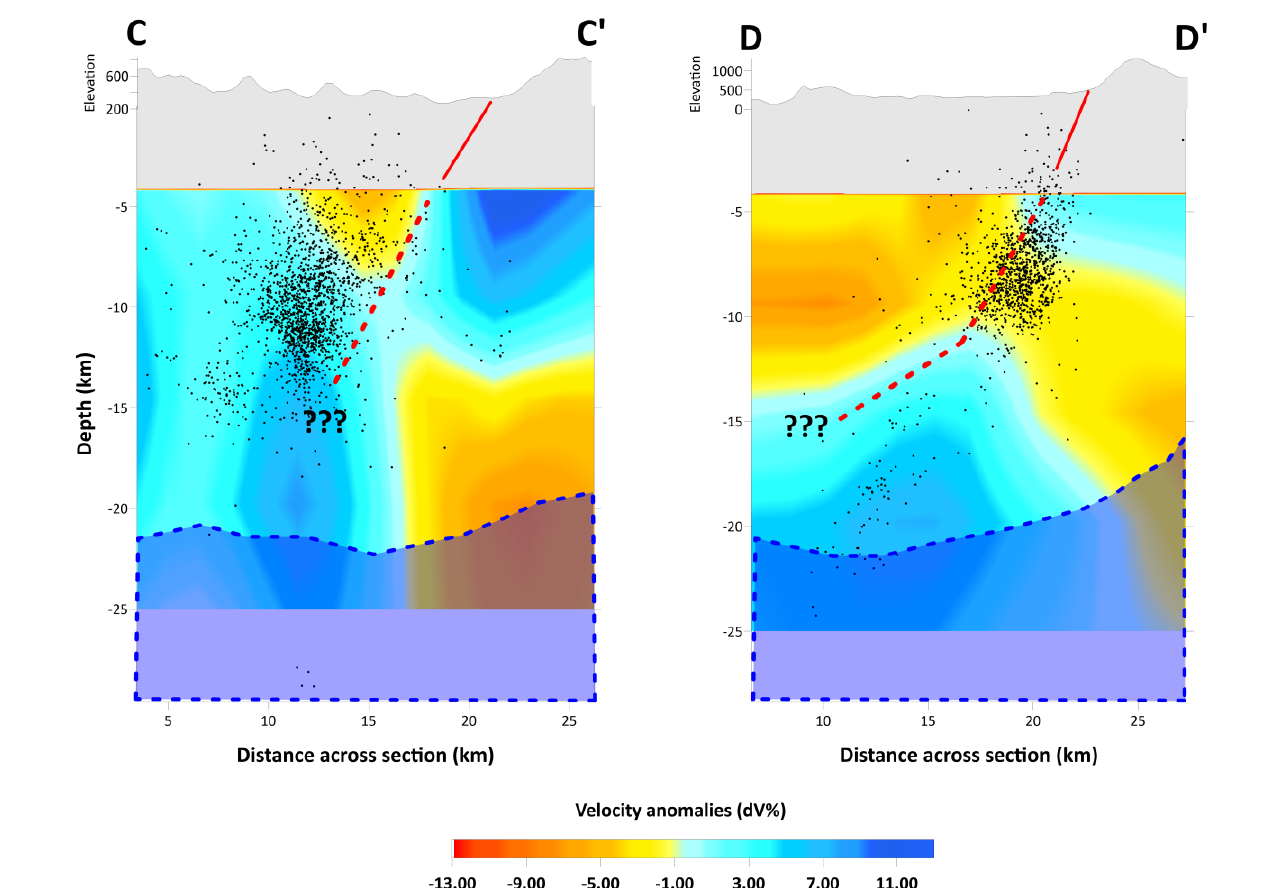
Figure 8. Cross-sections of V P (%) perturbations. The cross-section traces are the same with the first four ones of Figure 5.